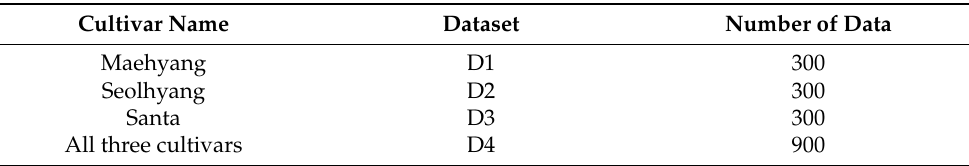
Table 1. Cultivar-wise compositions datasets and number of data fruit weight of strawberries during the testing and training